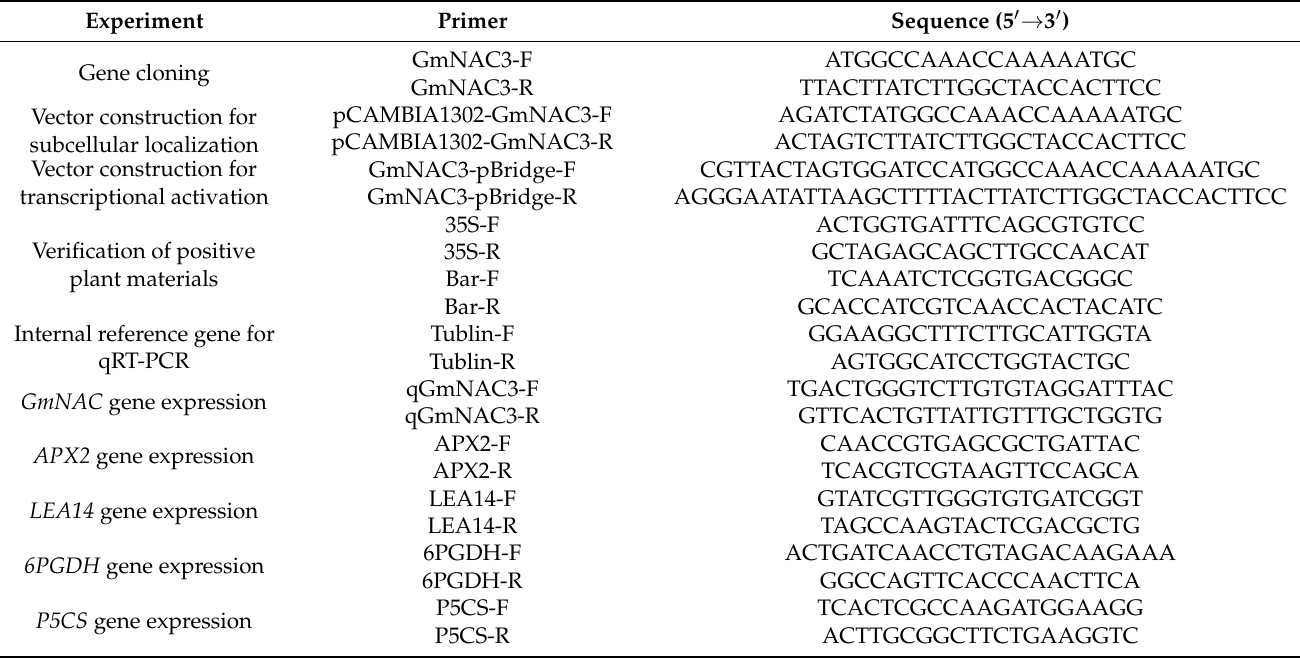
Table 3. Primers and their sequences used in this study. “-F” and “-R” stand for the forward and reverse primers,